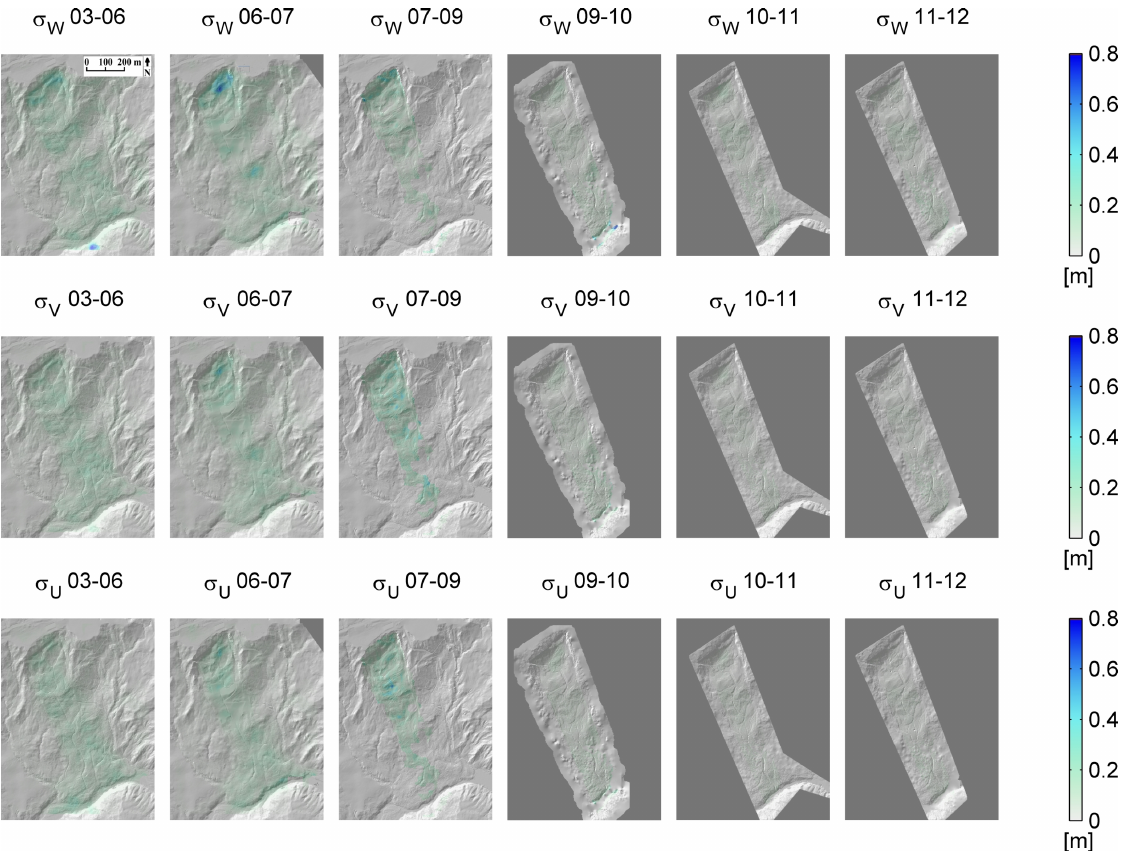
Figure 6. Standard deviation of estimated flow vectors from 2003 to